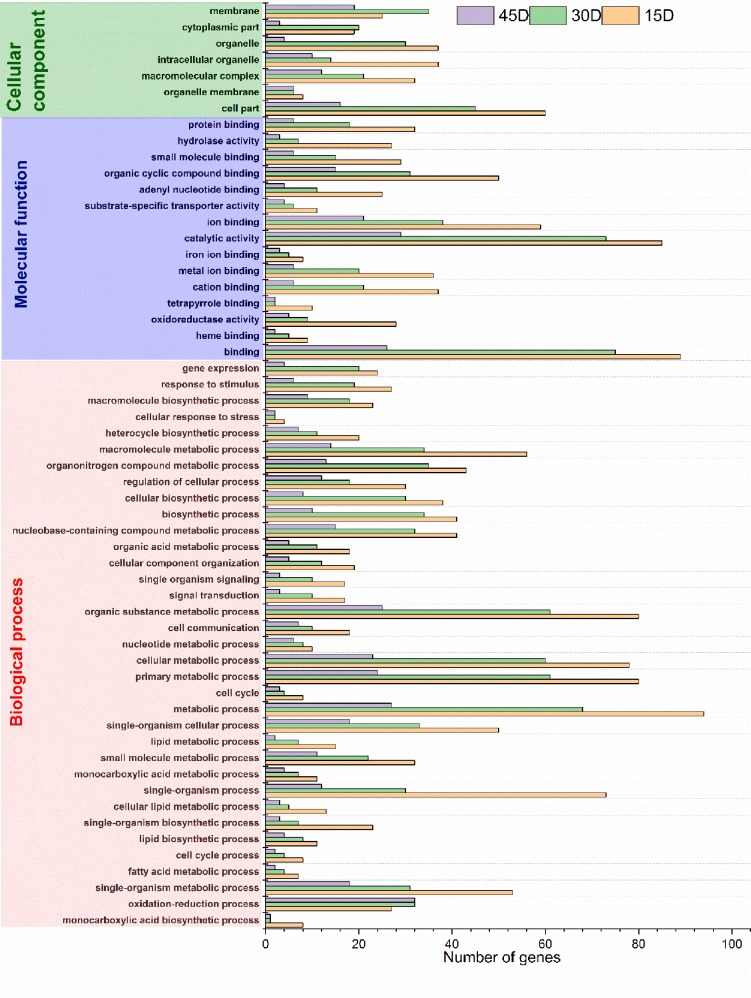
Gene Ontology (Go) classification of a differentially expressed genes.The Go term was categorized into biological process, cellular component, and molecular function. 15D, 30D and 45D indicated differentially expressed genes at days 15, 30 and 45 sugarcane roots in the response of strain MYSP113 inoculation.